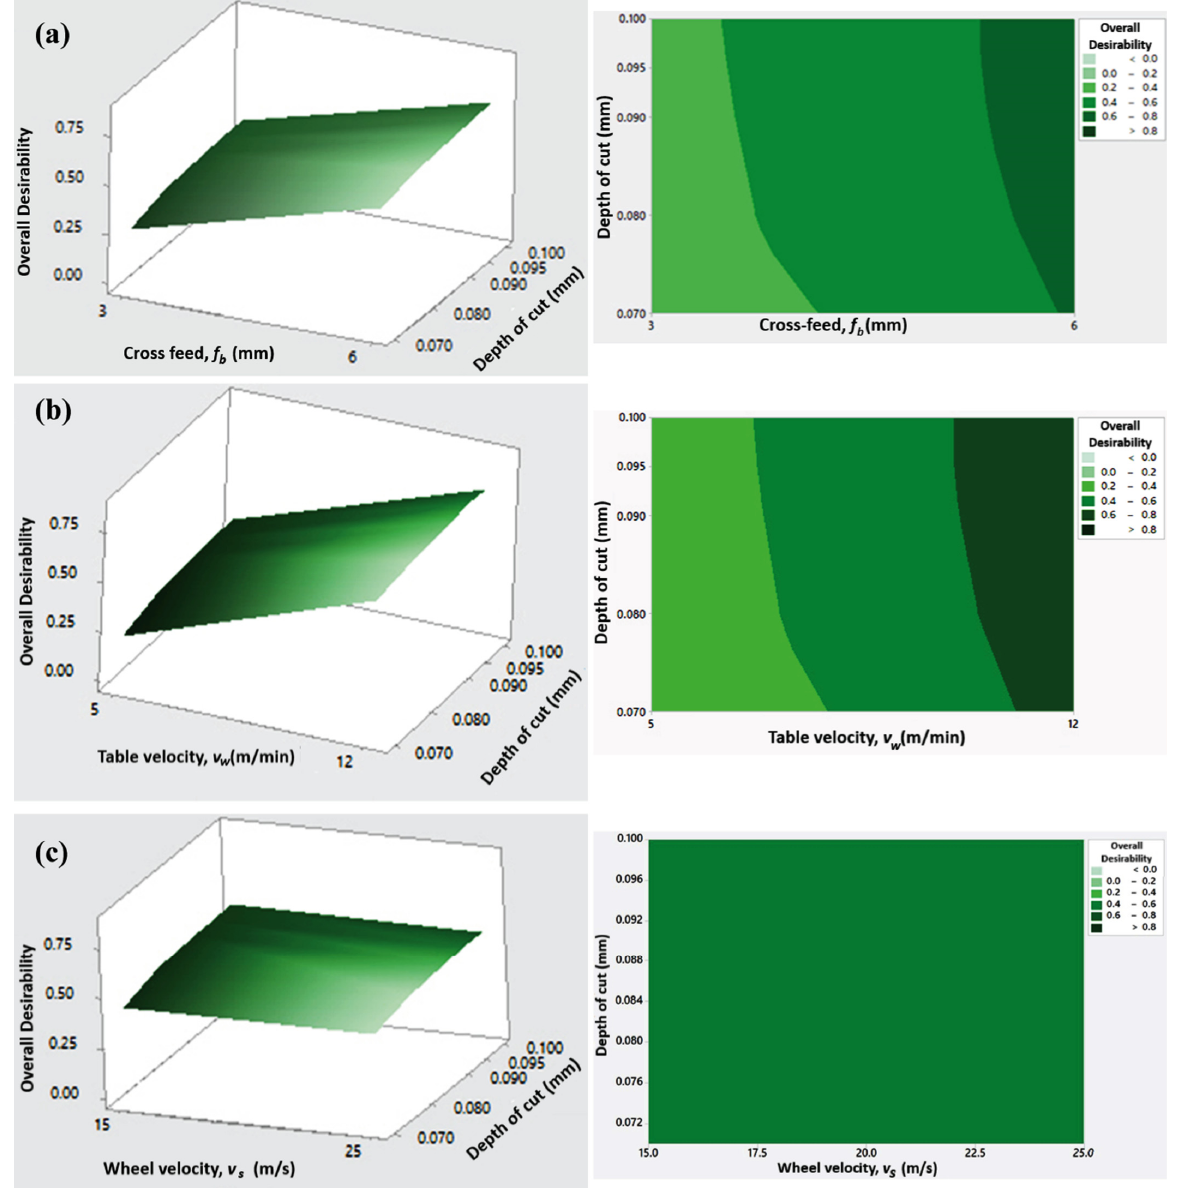
Figure 10. Surface plot and corresponding contour plot for overall desirability in wet condition (equal weightage). ( a ) show the combined effect of cross-feed and depth of cut, ( b ) table velocity and depth of cut and ( c ) wheel velocity and depth of cut on overall desirability.